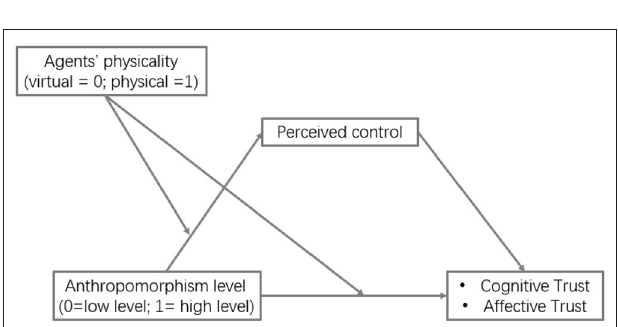
FIGURE 6 | Moderated mediation